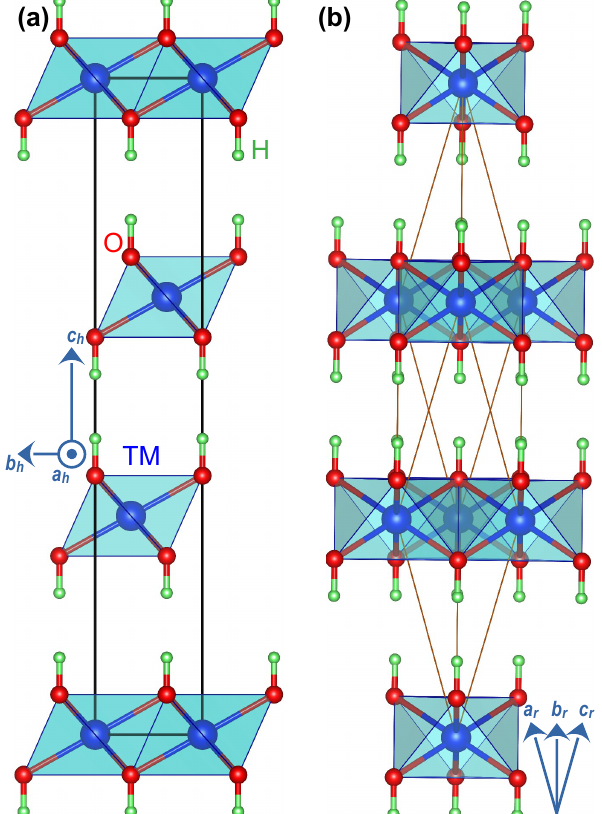
Figure 1. ( a ) The conventional cell of TM(OH) 2 layered double hydroxide compounds in hexagonal representation with group R ¯3 m and space group number 166. ( b ) The rhombohedral represen- tation of the same structure used for most calculations. In hexagonal representation, a h = b h , α h = β h = 90 ◦ , and γ h = 120 ◦ . In the rhombohedral presentation, the lattice parameters a r = b r = c r and α r = β r = γ r (cid:54) = 90 ◦ . The rhombohedral lattice parameters (denoted with subscript r ) are related to hexagonal lattice parameters (denoted with subscript h ) according to